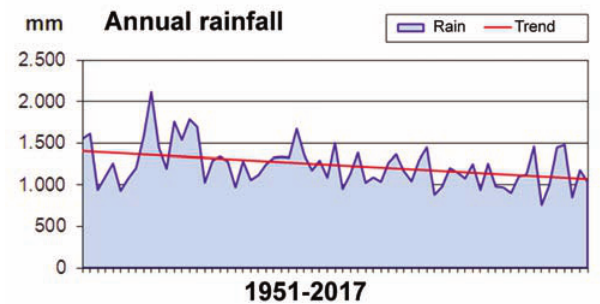
Fig. 5 - Annual rainfall values and trends in Pistoia (years 1951- 2017) (http://www.cespevi.it/meteo.htm; Paolo